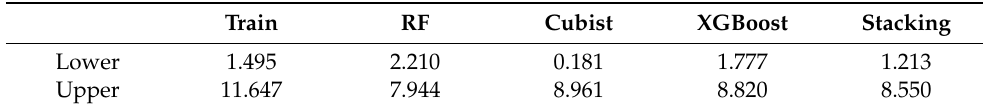
Table 2. Range comparison between the training set and the four models.